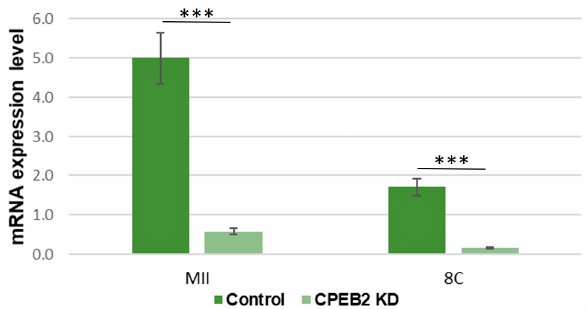
Figure 6. dsRNA efficiency of CPEB2 knockdown (KD) during oocyte maturation and early embryonic development. The relative abundance of CPEB2 mRNA was determined by qRT-PCR in porcine MII oocytes and parthenogenetic eight-cell (8C) embryos. CPEB2 transcript levels were normalized relative to the abundance of GAPDH mRNA (exogenous control) and are shown as means ± SEM ( n = 4 independent biological experiments with approximately 100 oocytes/embryos in each group). *** indicates statistical difference ( p < 0.001).